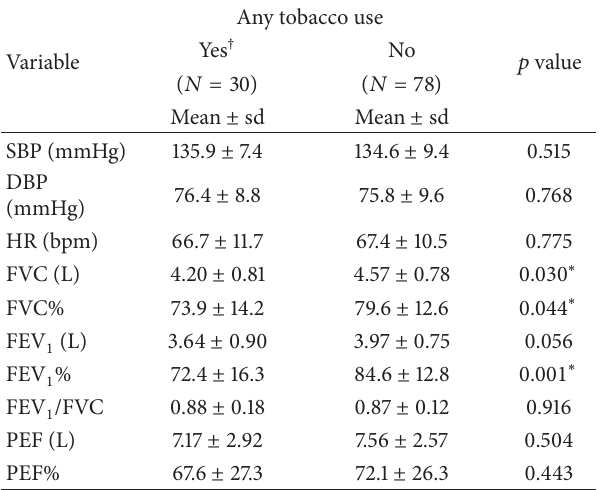
Table 2: Association between tobacco use and health indicators. Any tobacco Variable